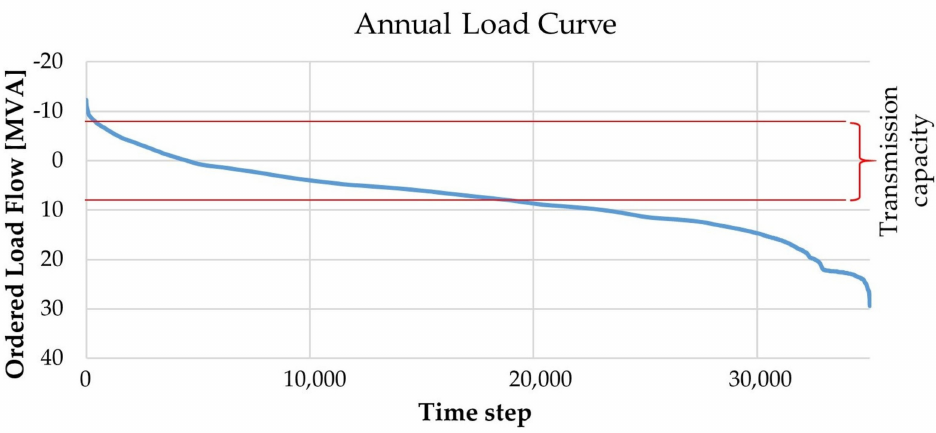
Figure 17. Annual load curve of a power branch line (ranked from min to